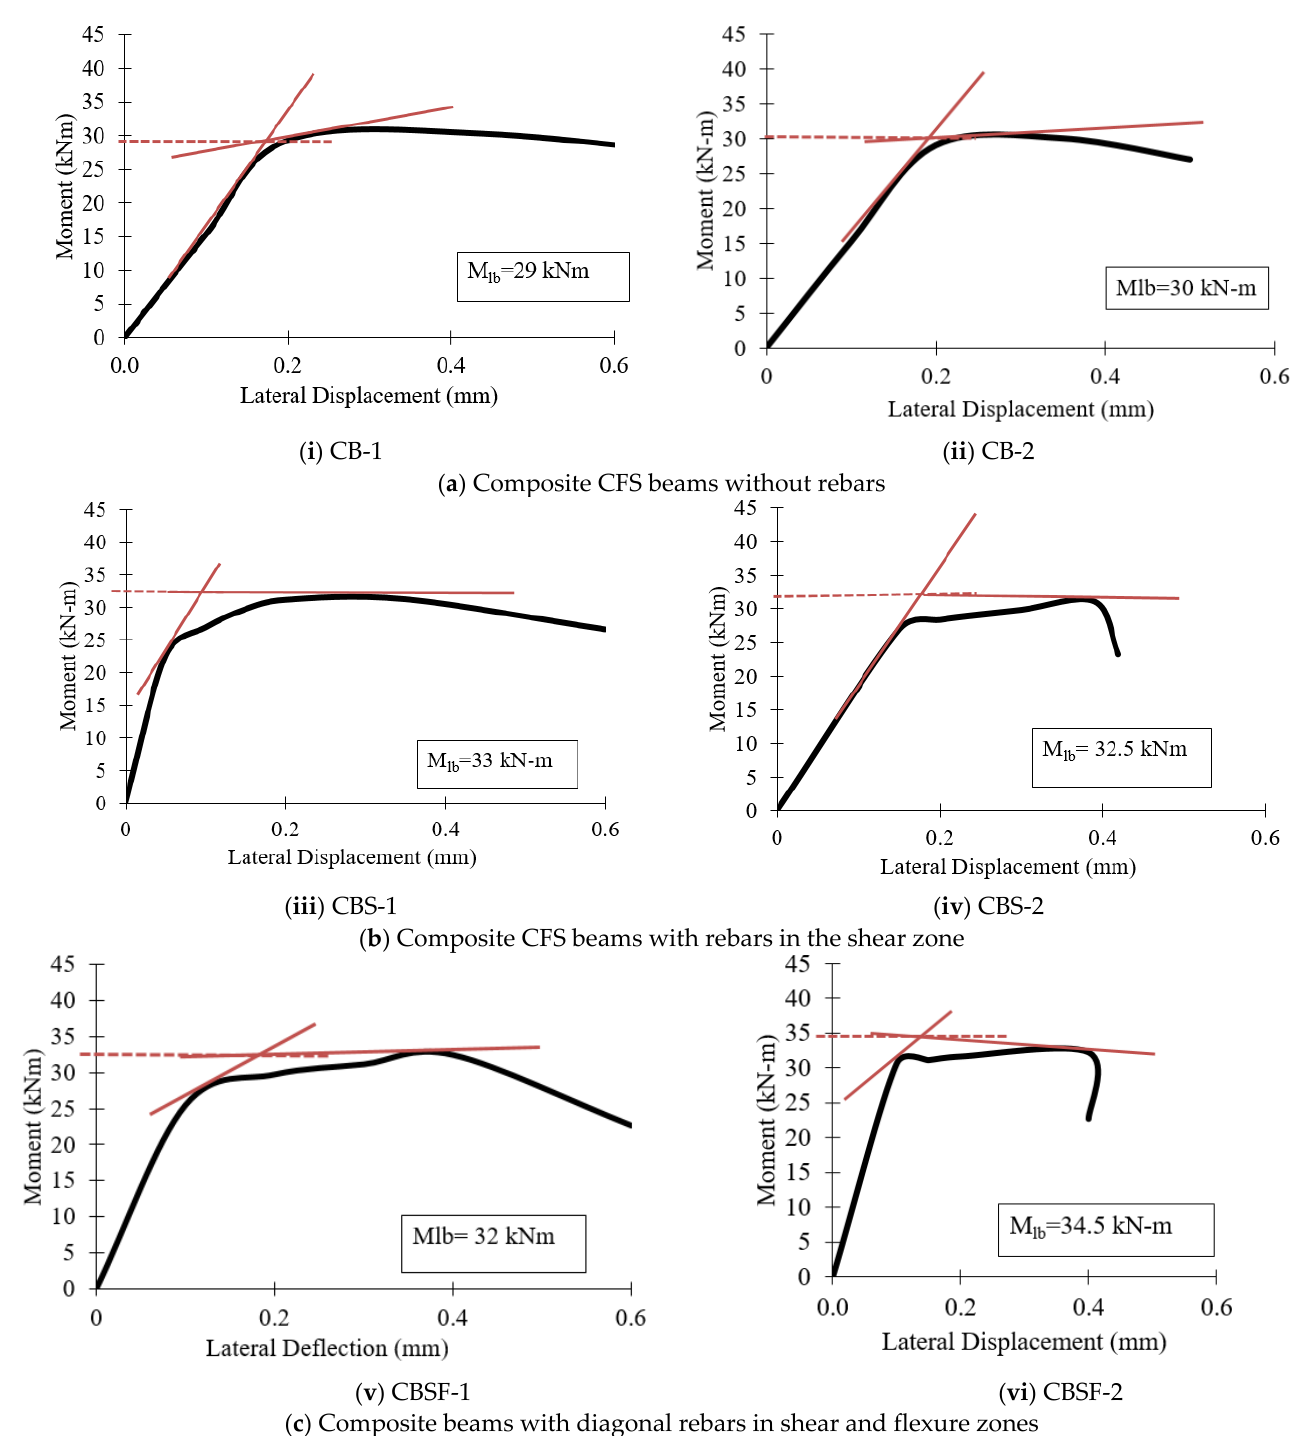
Figure 15. Moment – lateral displacement curves of the composite beams. Figure 16 shows that plain CFS beams with diagonal rebars in the shear and flexure zone (PBSF) and composite CFS beams with diagonal rebars in the shear and flexure zone (CBSF) performed well and had higher lateral buckling moments.